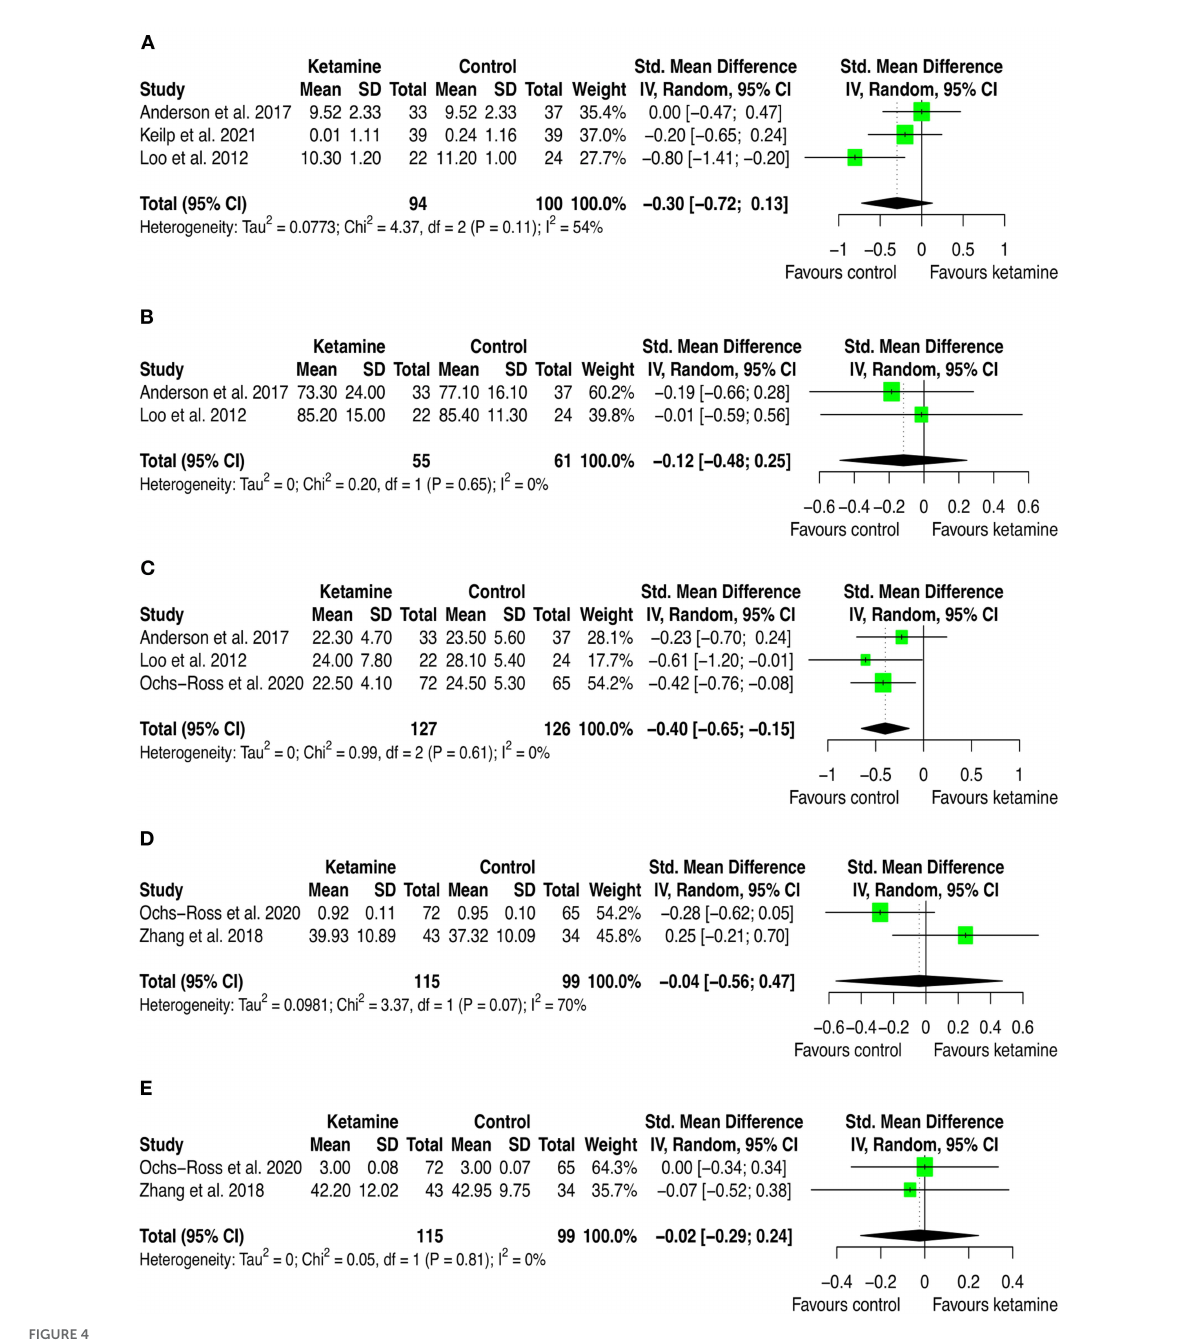
FIGURE4 Forest plots of performance comparisons among experimental and control groups on Recognition discrimination (A) , Retention (B) , Total learning (C) , Visual learning (D) , Working memory (E) . SD, standard deviation; IV, inverse variance; 95% CI, 95% confidence interval. x axis labels have been edited according to the characteristics of the outcome: since higher scores indicate better performance the label “Favors ketamine” is on the right-hand side.